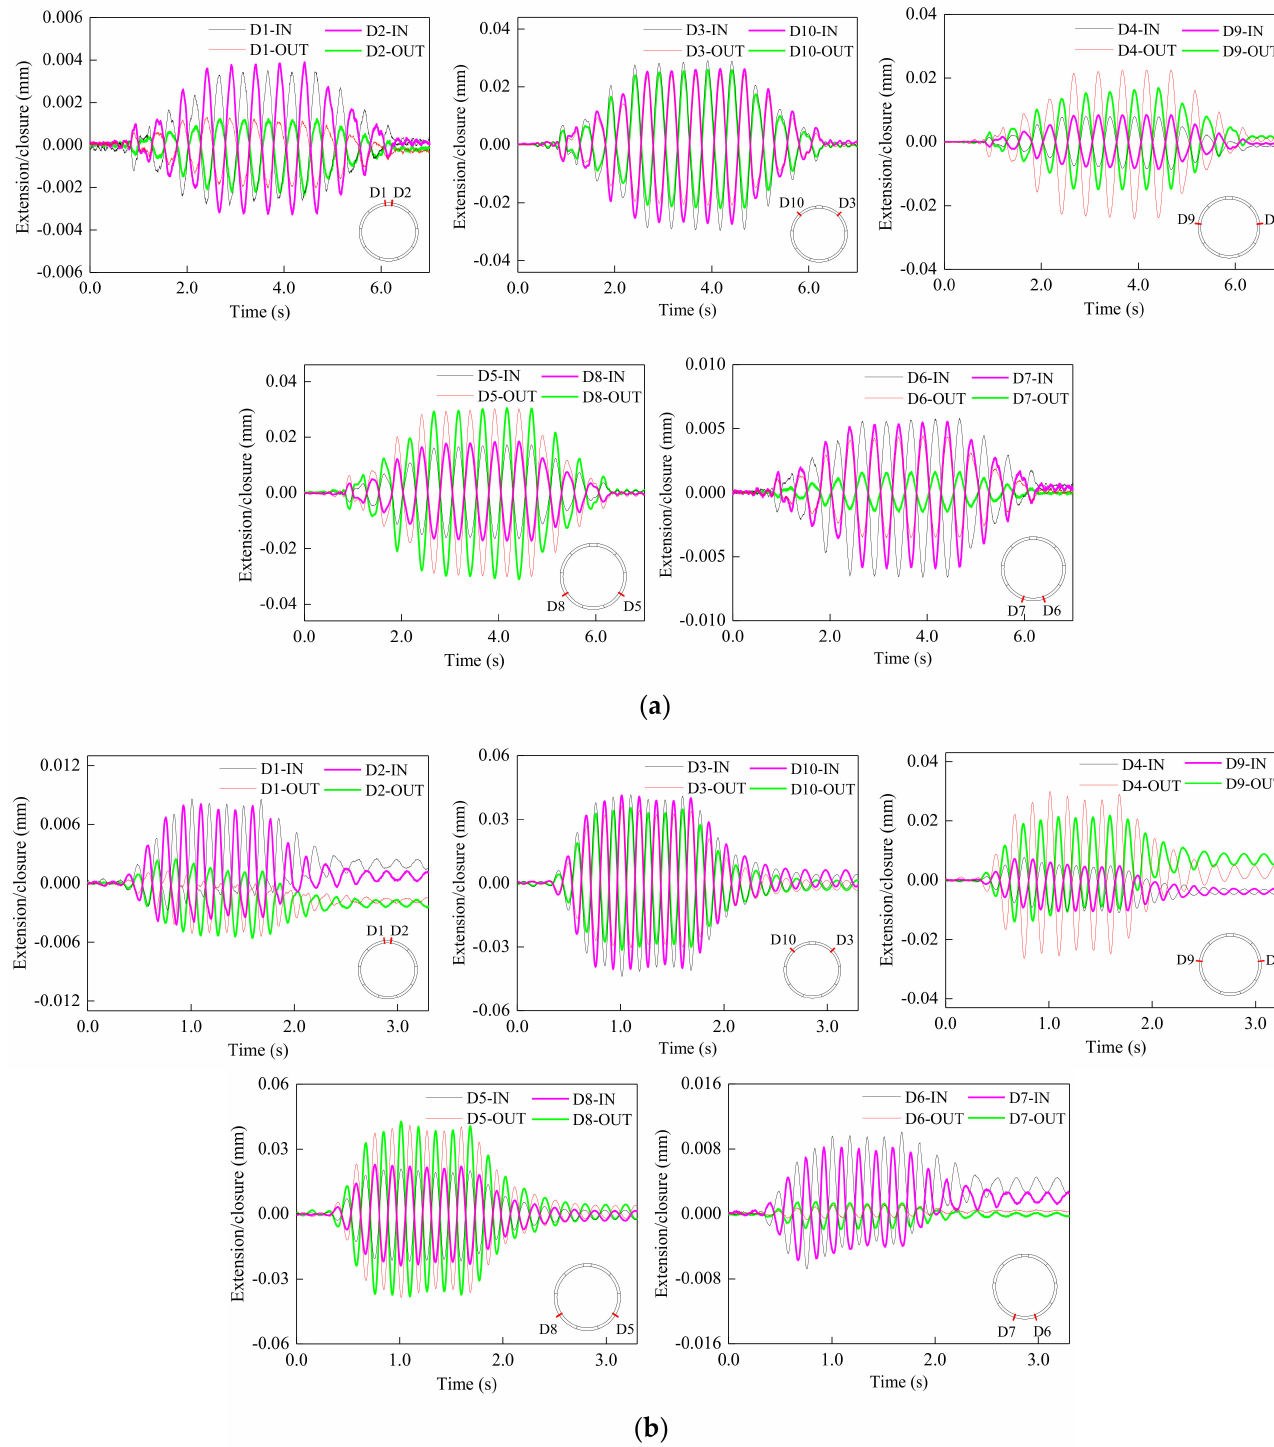
Figure 21. Extension/closure of longitudinal joints. ( a ) Sin-2. ( b )